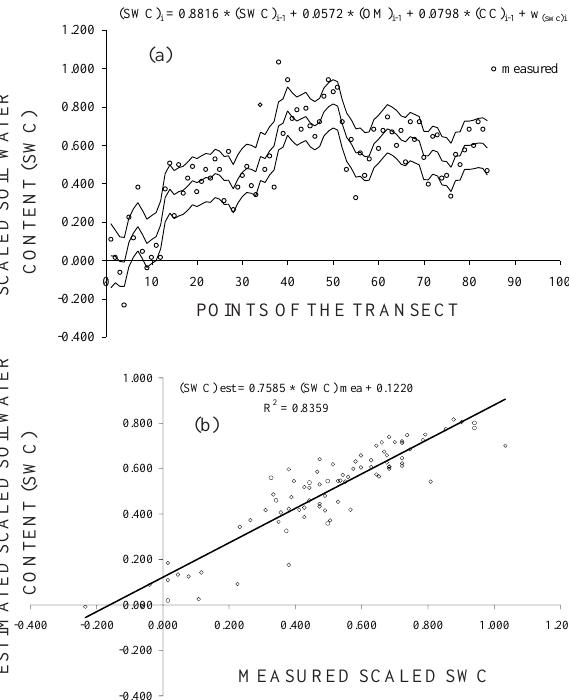
Figure 5. State-space analysis of scaled soil water content data as a function of scaled soil water content, scaled soil organic matter and scaled clay content at location i-1 (a); correlation between estimated and measured scaled soil water content data of (a) (b).